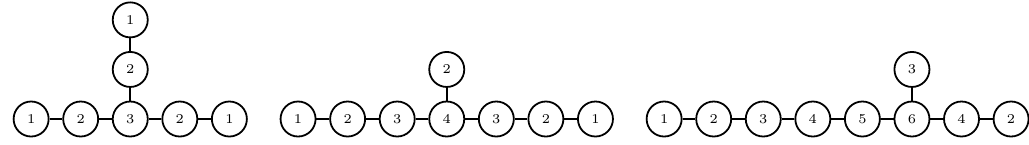
Figure 25 . From left to right the quivers of E 6 , E 7 and E 8